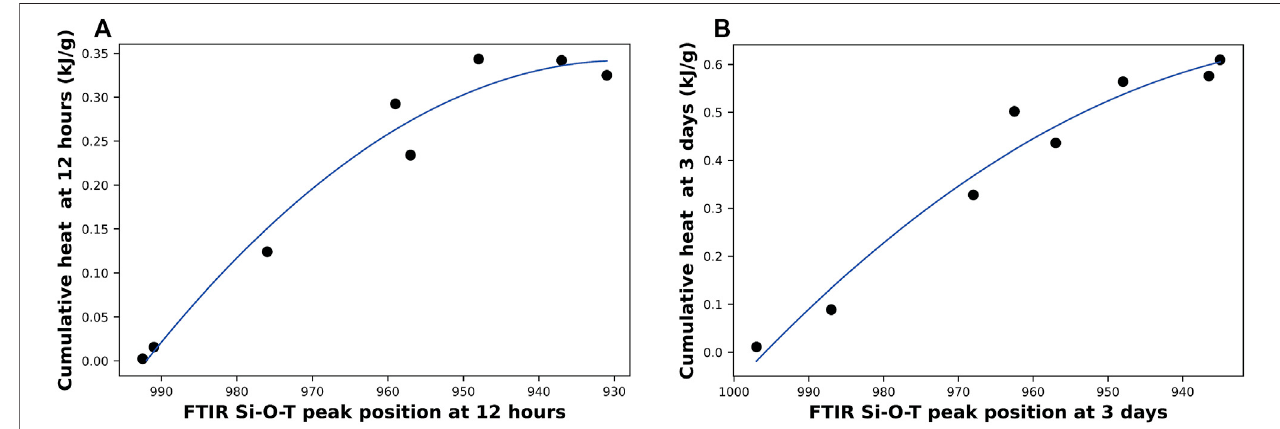
FIGURE 8 | A correlation between the total heat generated from isothermal calorimetry and the position of the Si-O-T peak from FTIR scans after (A) 12 h of hydration and (B) 3 days of hydration. Each data point represents a different Na/Al ratio (0.6 – 1.8).